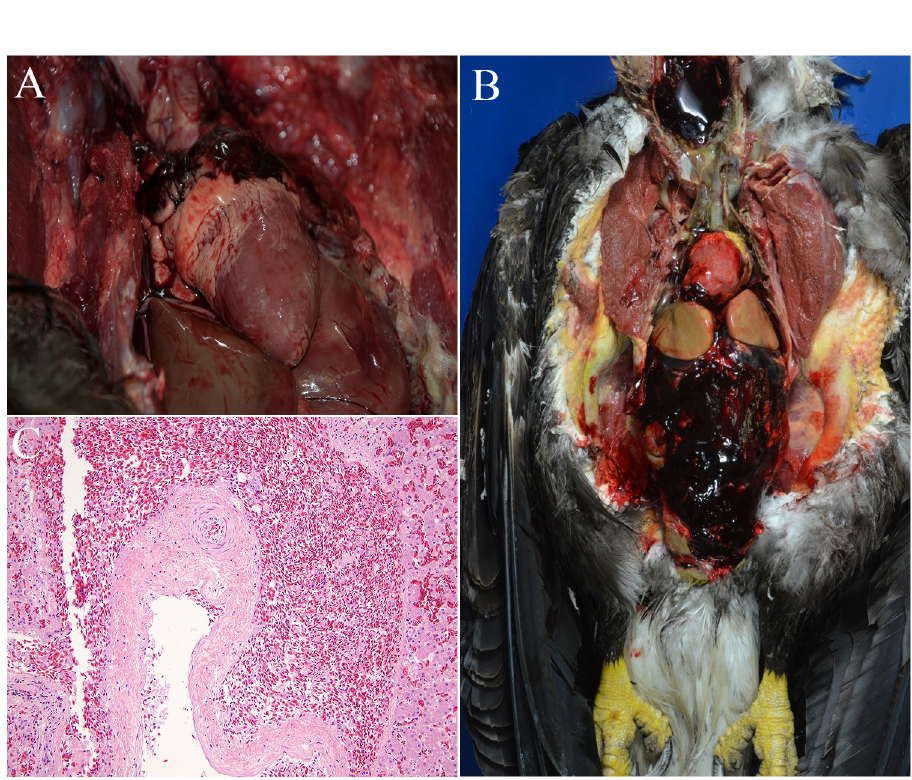
Fig 3. Lesions associated with AR toxicosis in eagles. A: A bald eagle with unclotted blood surrounding the base of the heart within the coelom. B: A bald eagle with abundant, unclotted blood overlying the liver and surrounding the heart and filling much of the coelomic cavity. C: Photomicrograph of the liver from a bald eagle showing abundant erythrocytes (hemorrhage) outside an arterial wall and spilling into the adjacent parenchyma. Hematoxylin and eosin (HE)